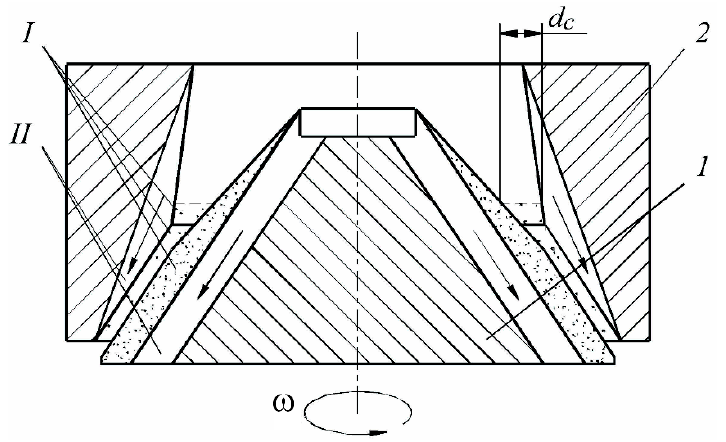
Figure 14. The scheme of movement of cream cheese mass in the channels of the rotary–vortex emulsor. 1—rotor, 2—stator; I—zone of transportation and mechanical treatment of cream cheese mass; II—zone of transportation without mechanical processing of cream cheese mass.